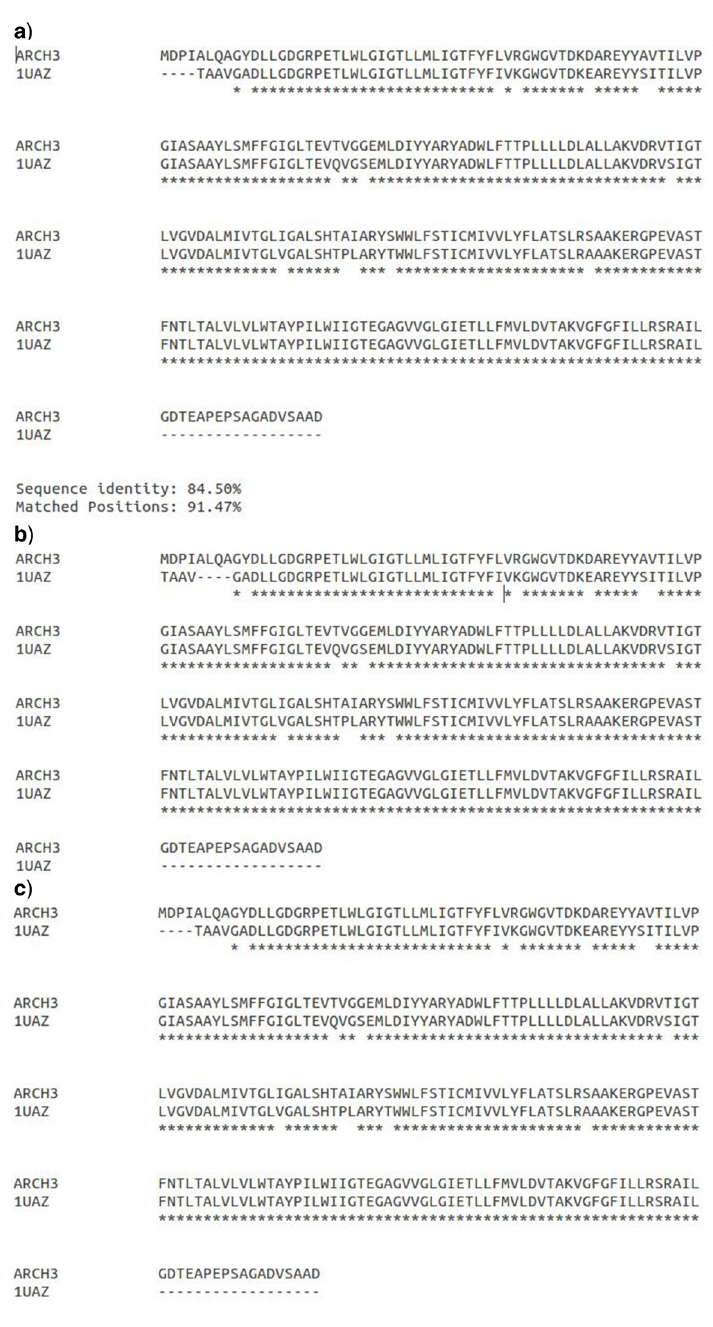
Figure 1. The results of the pairwise sequence alignment algorithms: a ) AlignMe; b ) MP-T; c )